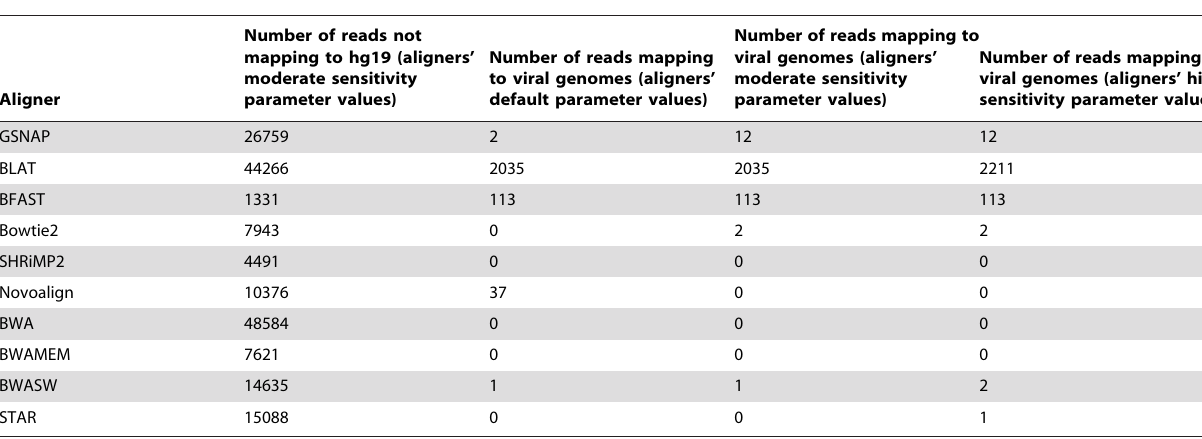
Table 9. Human reads simulated from host genomic regions not represented in the human (hg19) reference genome.